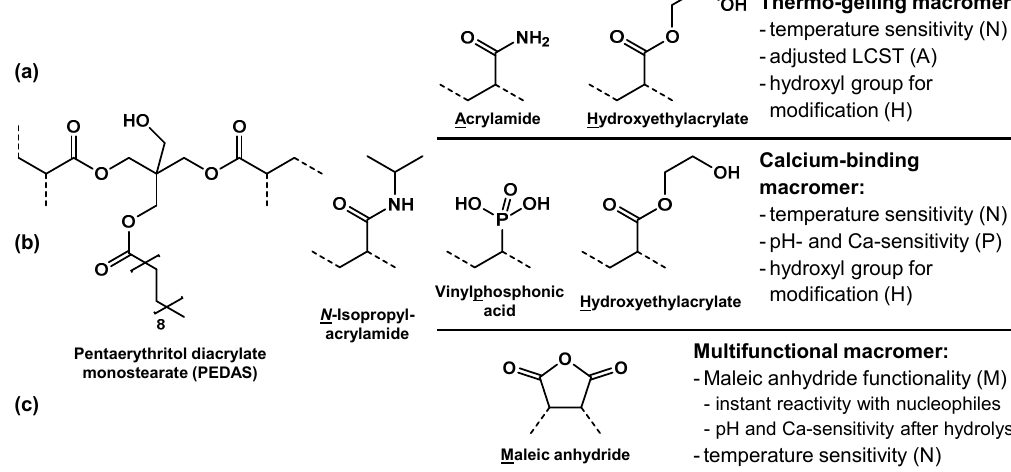
Figure 3. Amphiphilic pentaerythritol diacrylate monostearate (PEDAS)- and NiPAAm-based macromers with a list of key properties imparted by the constituent comonomers abbreviated by the underlined character in the macromer name. Dotted lines illustrate the polymeric backbone of the macromer. ( a ) Thermogelling macromer that was rendered chemically gellable after methacrylation of H [52]; ( b ) Calcium-binding macromer with vinylphosphonic acid as comonomer [55]; ( c ) Multifunctional maleic anhydride-containing macromer [56].